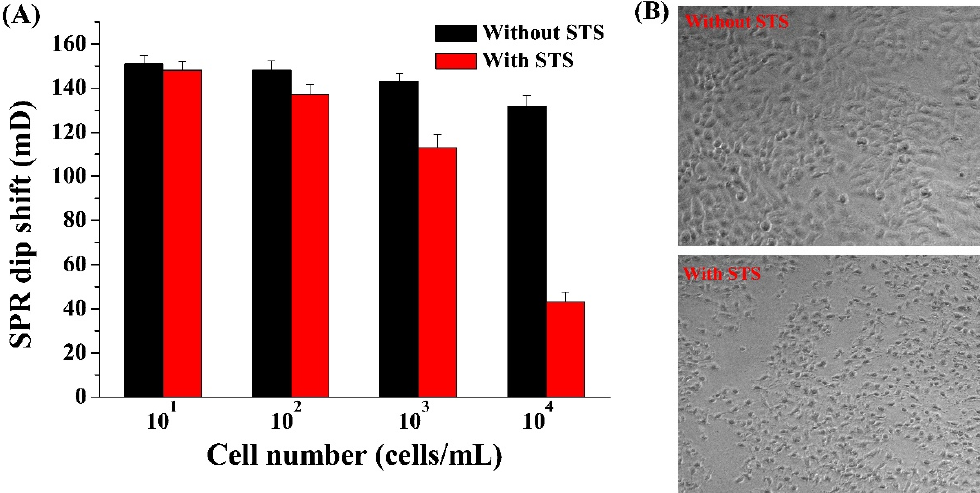
Figure 4. ( A ) Dependence of SPR signal on the concentration of normal and STS-treated HeLa cells. ( B ) Confocal images of normal and STS-treated HeLa cells.